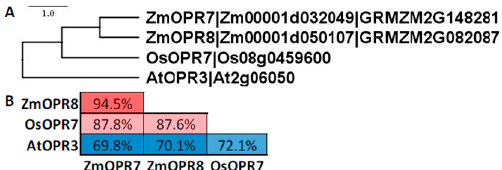
Figure 8. Amino acid sequences of Type II OPR family members from Arabidopsis , maize, and rice compared with ClustalX and visualized with Figtree. ( A ) Gene labels follow nomenclature from maize [91] and rice [92]. ( B ) Identity analyses was performed with SIAS. The color code (red to white to blue) scale represents the percent sequence identity from greatest to least.